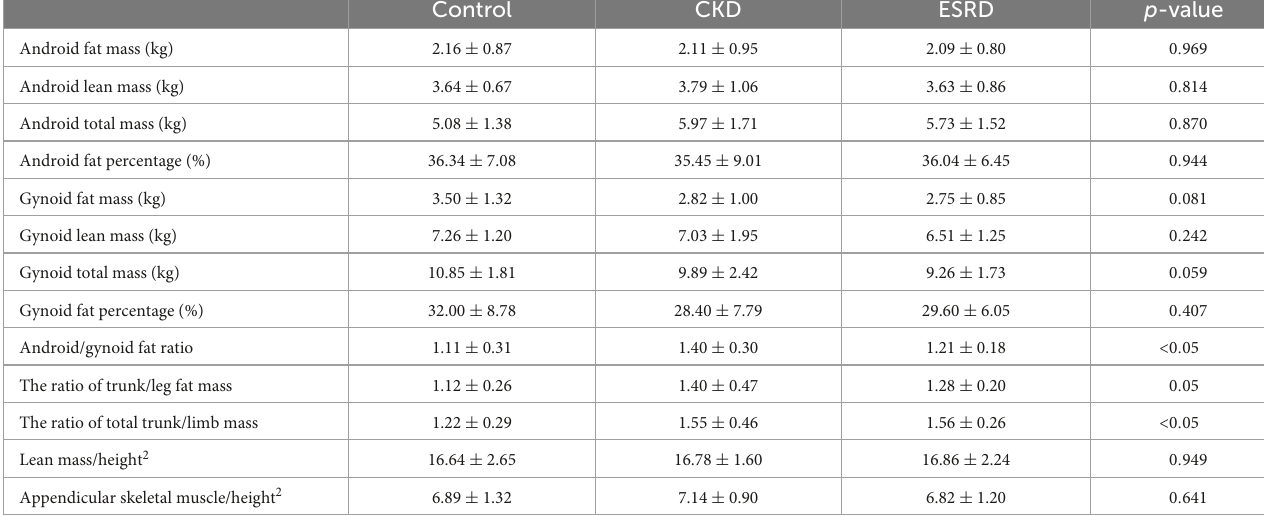
TABLE 7 Dual-energy X-ray absorptiometry parameters by group.